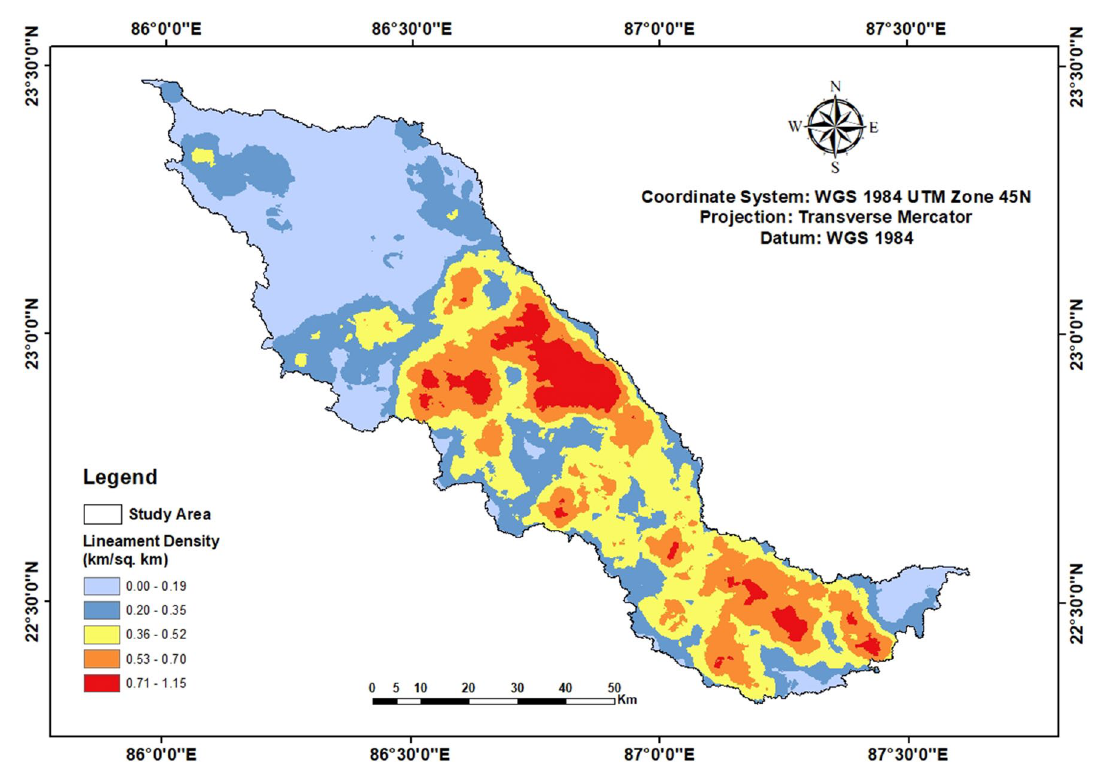
Fig. 4 Spatial distribution of lineament density of Kangsabati River